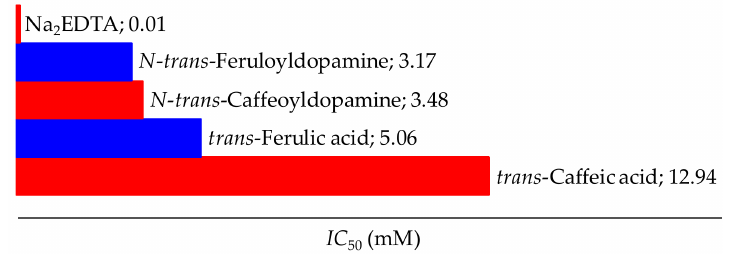
Figure 3. Chelation ability of tested